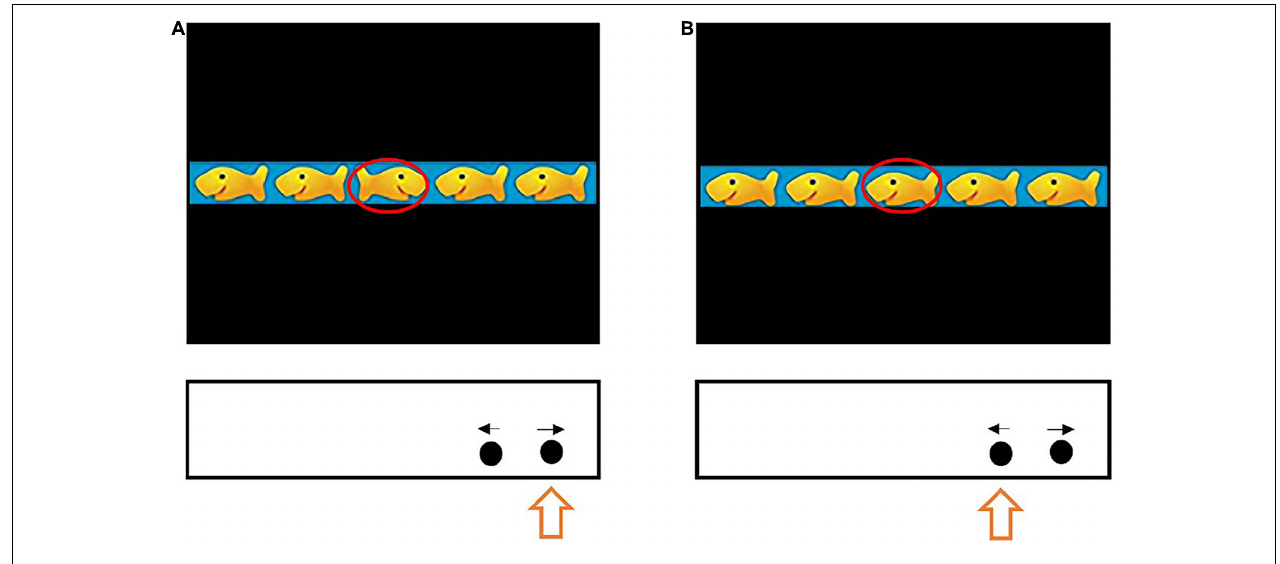
FIGURE 1 | Fish flaker